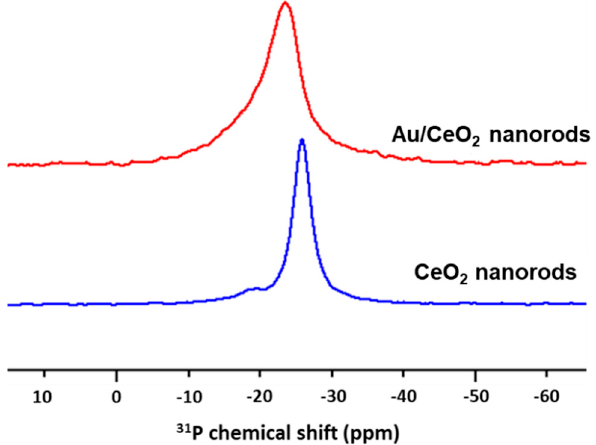
Figure 2. 31 P ss NMR spectra of CeO 2 and Au / CeO 2 nanorods (blue and red traces, respectively) using trimethylphosphine (TMP) as a surface probe. After Au deposition, the 31 P NMR signal shifted from 25.7 to 23.5 ppm, suggesting that the electron density of the Ce surface is decreased upon Au deposition.